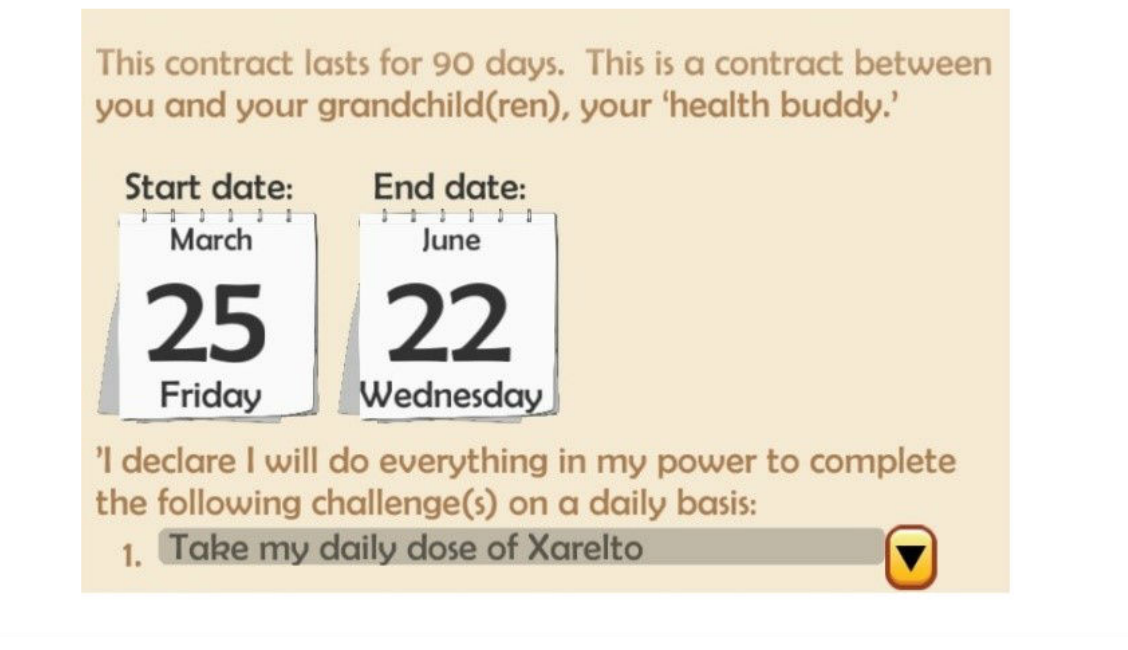
Figure 1. Screenshot of the Health Buddies app representing the contract after filling out the daily challenge.